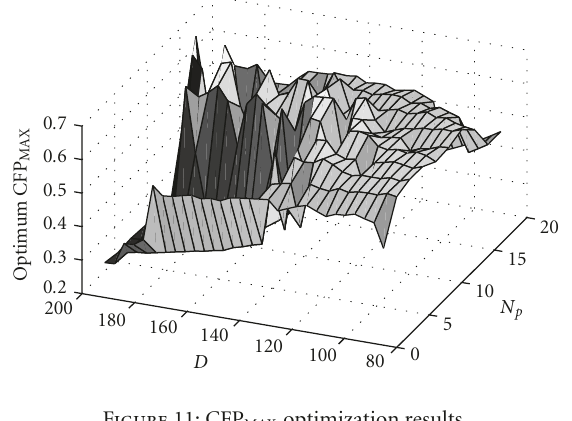
Figure 11: CFP MAX optimization results.